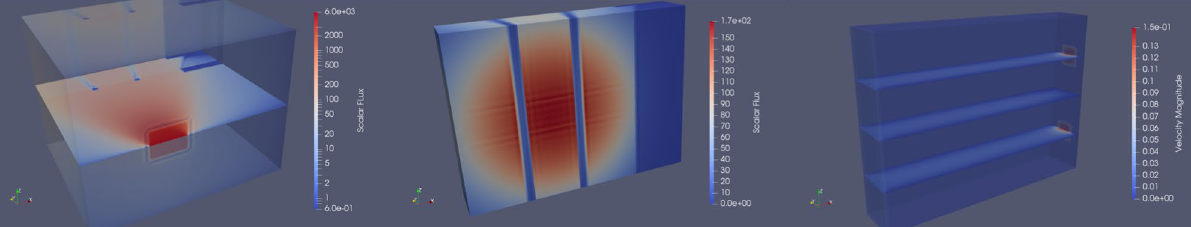
Figure 2. Left: Far-UVC intensity (the fluence rate, µ J.cm − 2 .s − 1 ) in the region spanned from the lamp surface to the back wall of the chamber. The high intensity red rectangular region in the foreground denotes the position of the lamp. Middle: Far-UVC intensity within the chamber. The vertical bars indicate the shadows cast by the support rods. Right: Fluid velocity magnitudes for developed aerosol flow, from left to right, within the